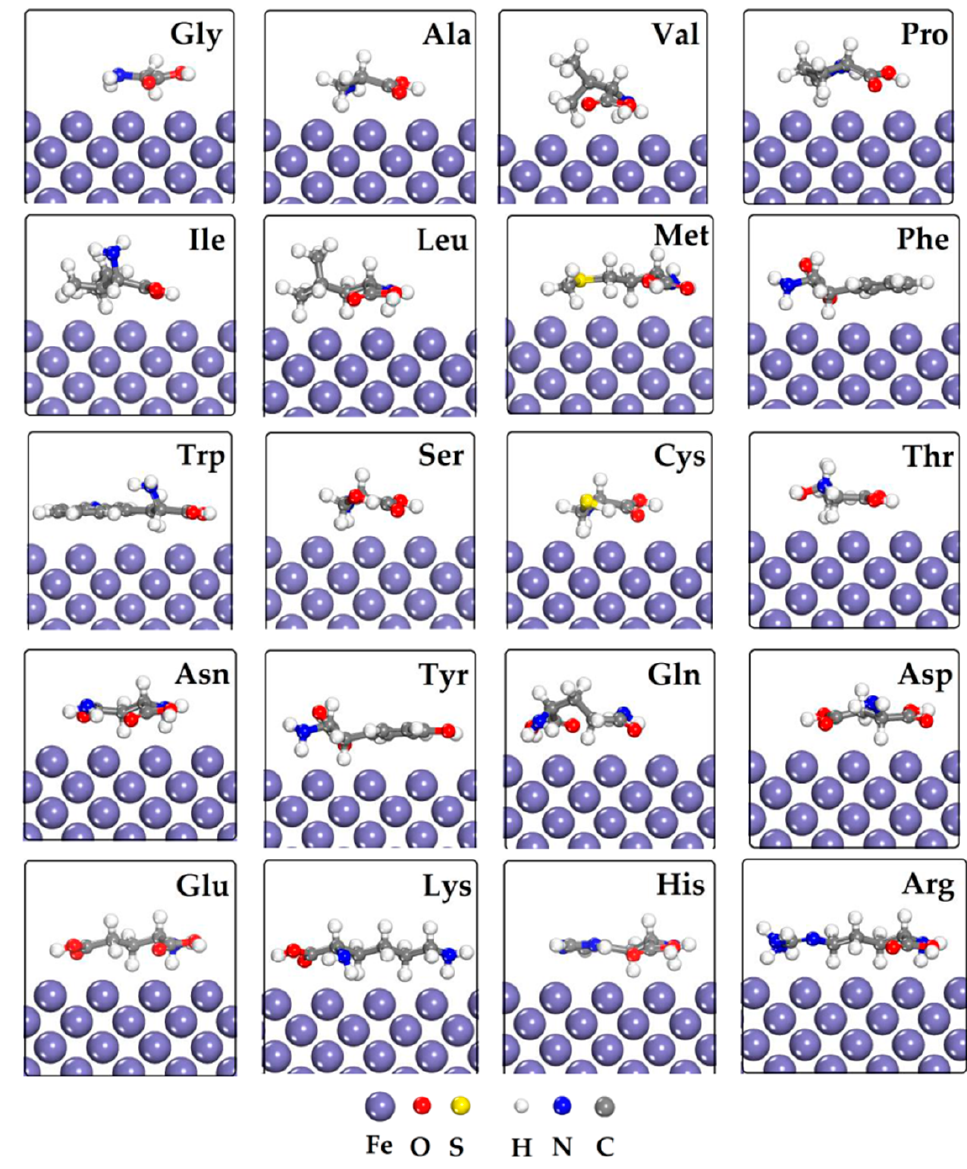
Figure 4. The side view of the most stable low-energy configurations calculated by the MC simulation for the adsorption of L-amino acids on the Fe (100) surface.